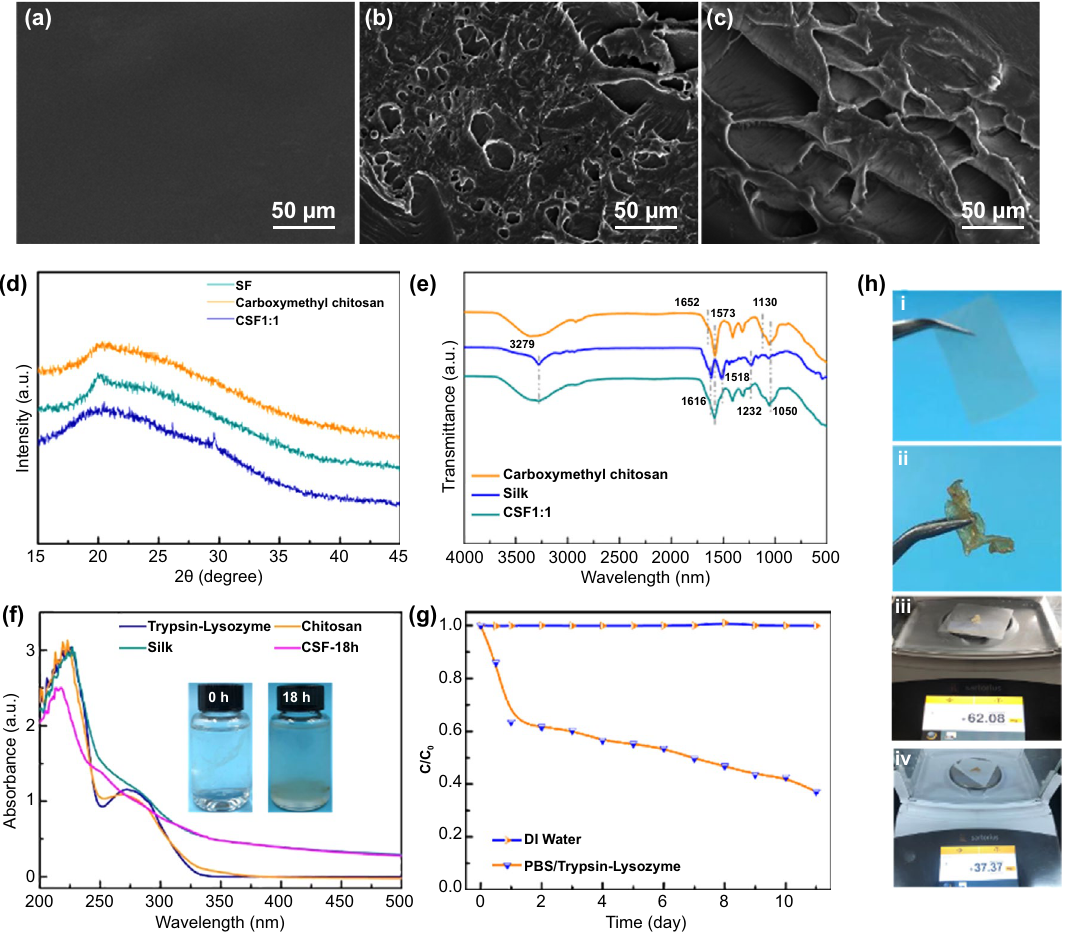
Fig. 2 Microscopic images, structure, and biodegradation performance of CSF film. a–c Scanning electron microscopic images of SF, carboxy- methyl chitosan, and CSF film. d XRD spectra of SF, carboxymethyl chitosan, and CSF film. e FTIR spectra of SF, carboxymethyl chitosan, and CSF film. f Changes of the characteristic absorption after biodegradation by Trypsin-Lysozyme solution for 18 h. Trypsin-Lysozyme and photographs of residual CSF film solution (inset); g Biodegradation of CSF film by Trypsin-Lysozyme solution. h CSF film and photographs of residual CSF film ( i–ii ); Pictures of CSF film during the biodegradation process ( iii–iv